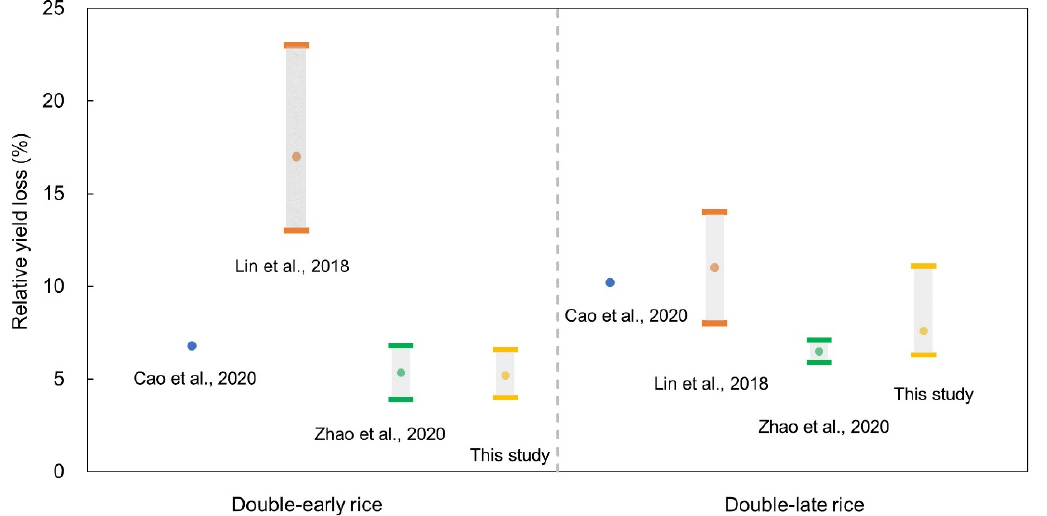
Figure 9. Comparison of relative yield loss between this study and other related research.